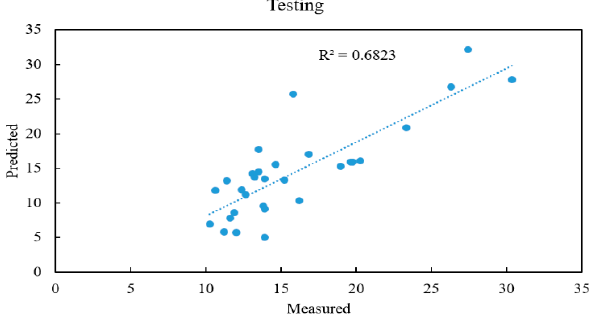
Figure 4. Testing results of Equation (6) for prediction of PPV.